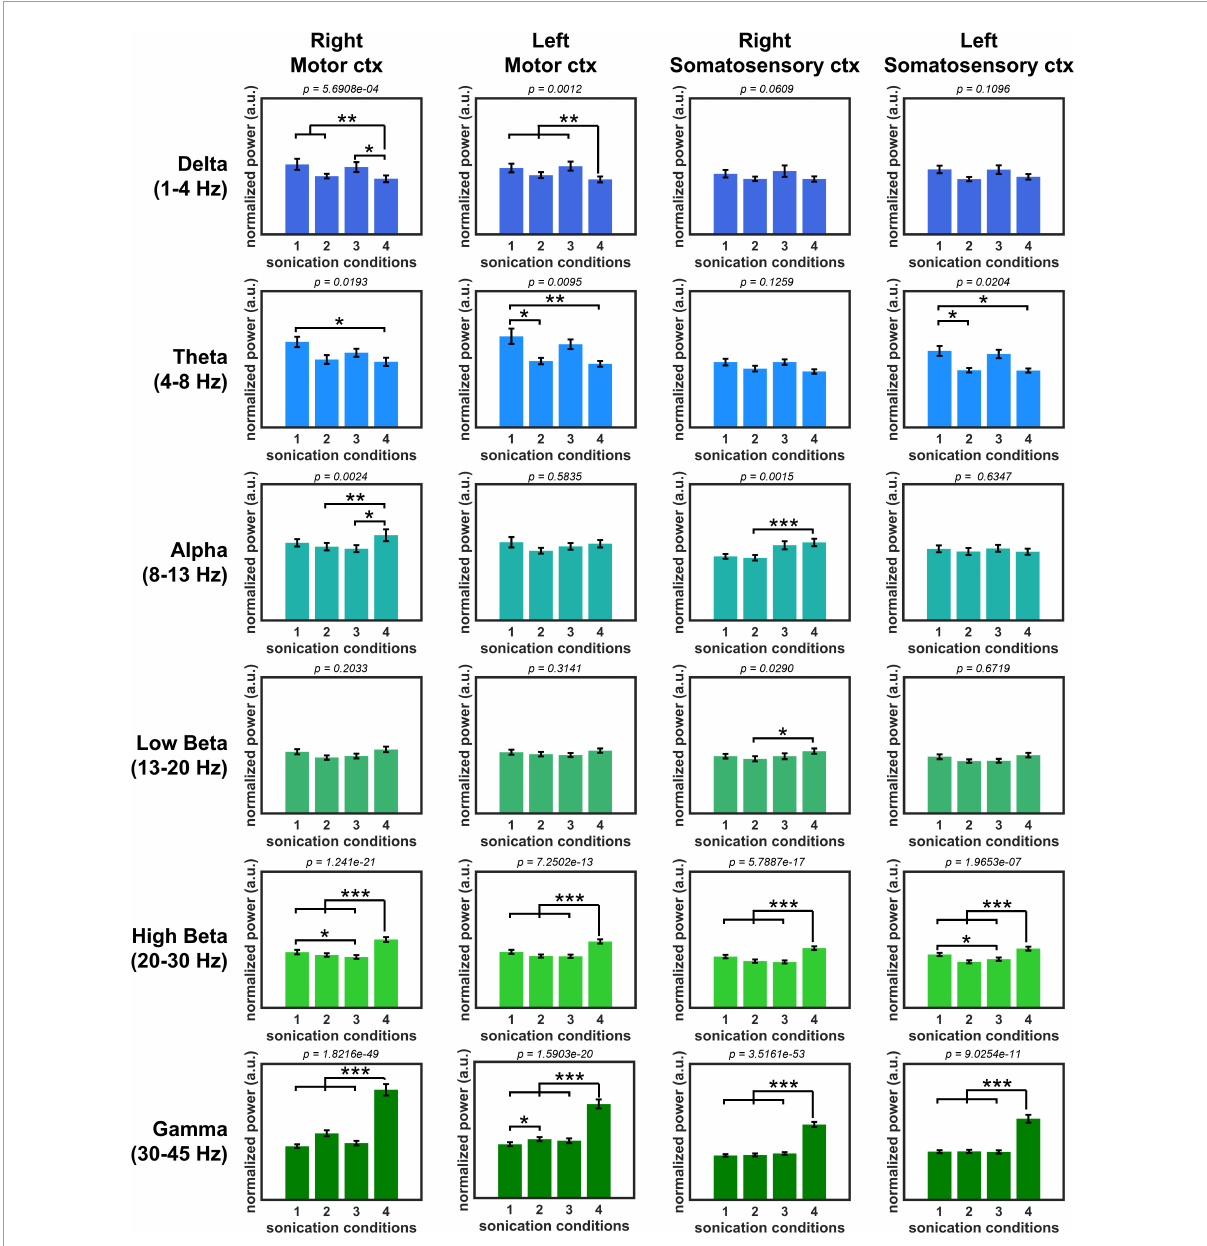
FIGURE4 Normalized oscillatory power with four sonication conditions. (* p < 0.05, ** p < 0.01, *** p < 0.001, Kruskal–Wallis, non-parametric one-way ANOVA followed by the Tukey–Kramer post hoc